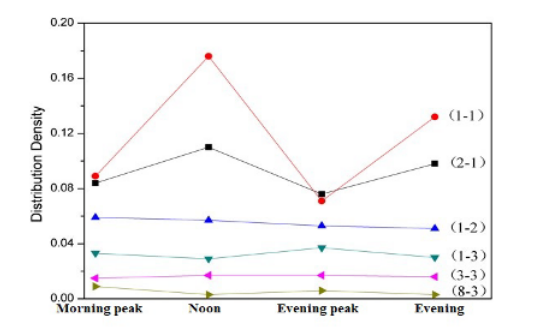
Fig. 5. Personnel density of typical sub-aeras in different times( τ = 10